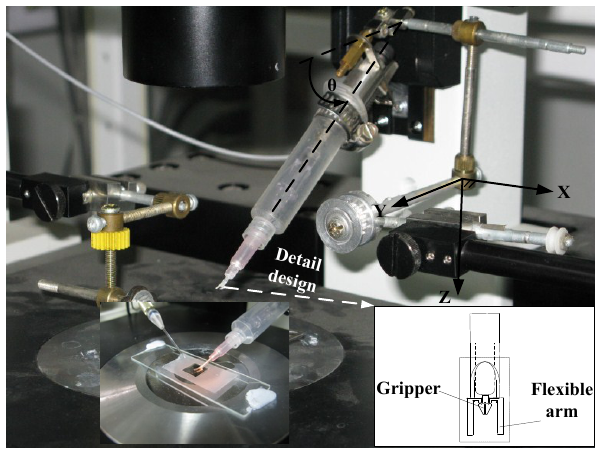
Figure 1. Micromanipulation system (overlapped by a photo of microgripper with bending flexible arms in liquid well).